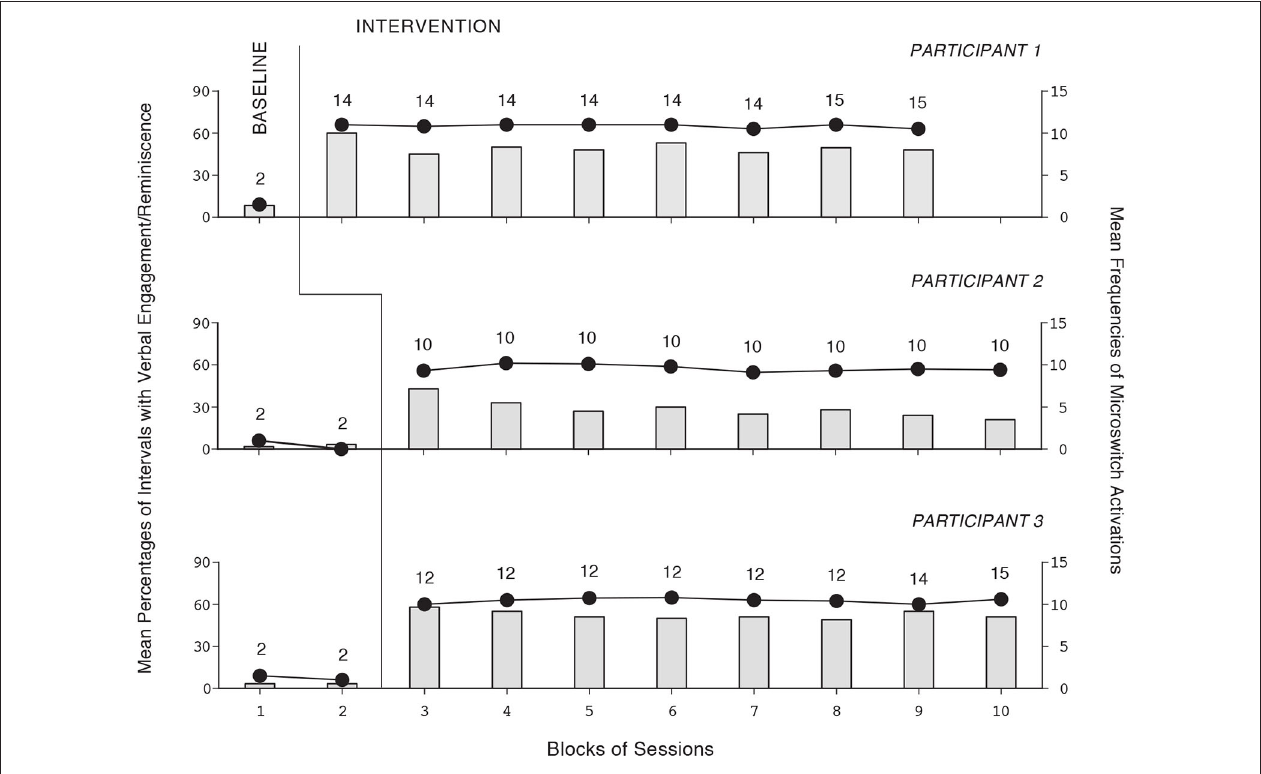
activations per session, respectively, over blocks of sessions. The number of sessions included in each block (i.e., bar-circle combination) is indicated by the numeral above